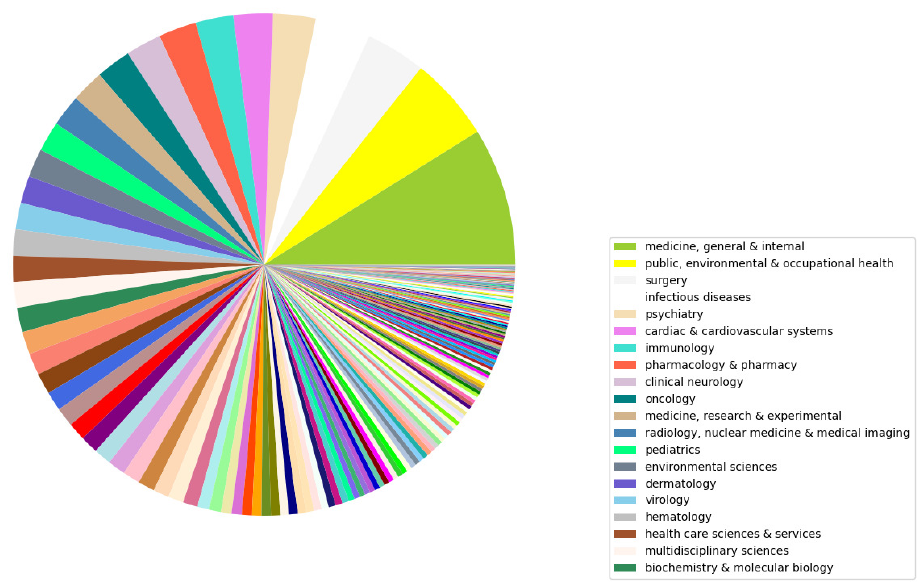
Figure 2. The areas covered in the COVID-19 articles; there are more than 220 areas in this figure.